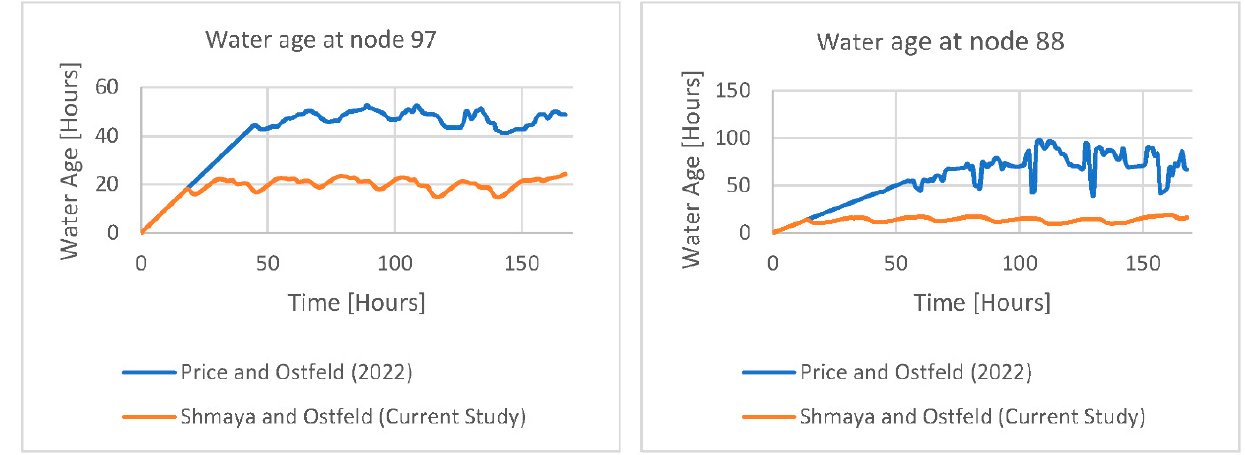
Figure 5. Water age at node 97 ( left ) and node 88 ( right ) throughout the simulation.